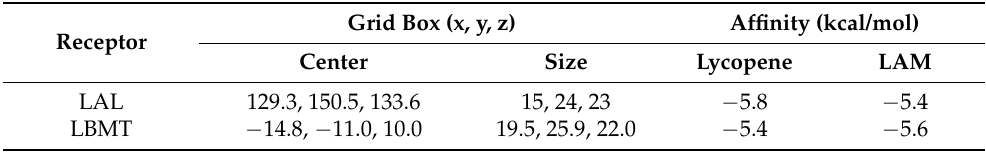
Table 1. The grid box parameter (center and size) and docking binding affinity (Kcal/mL) of lycopene and lipid A monomer (LAM) for some proteins involved in producing K. pneumoniae lipopolysaccharide.